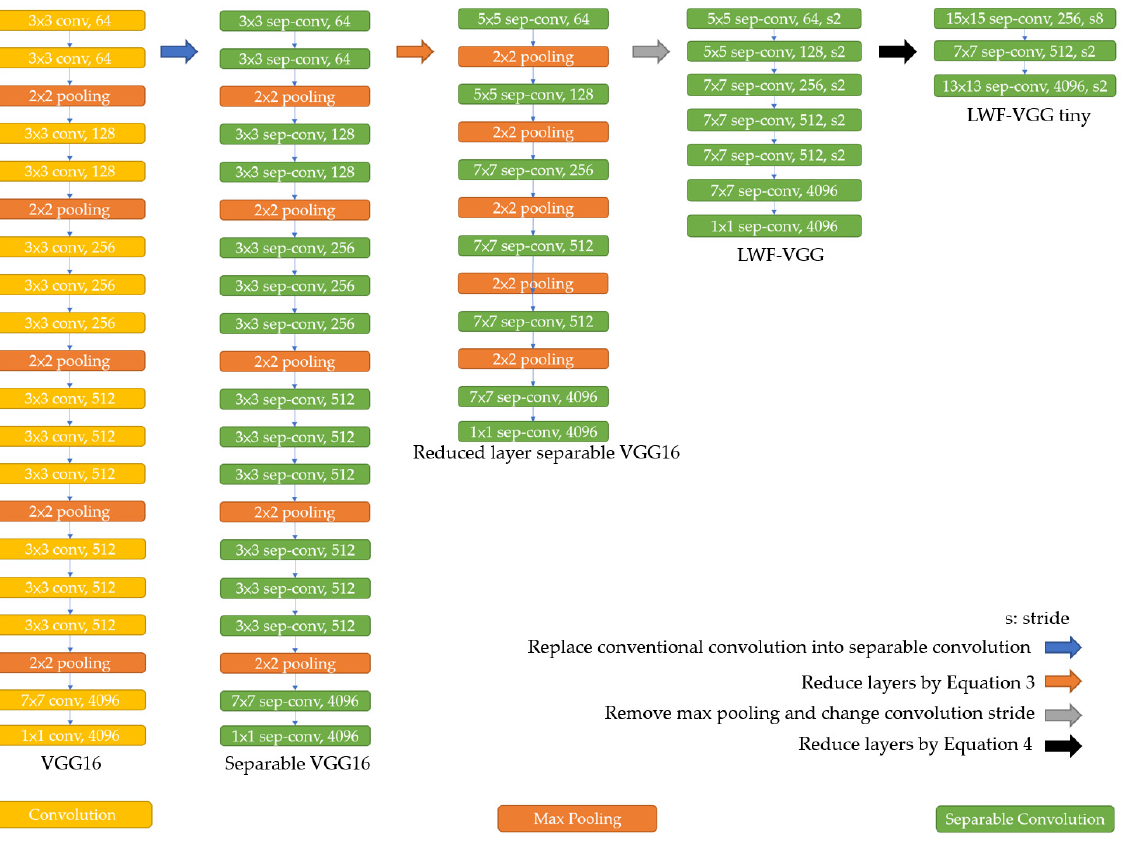
Figure 10. (upper) VGG16 classifier (lower) VGG16 FCN.